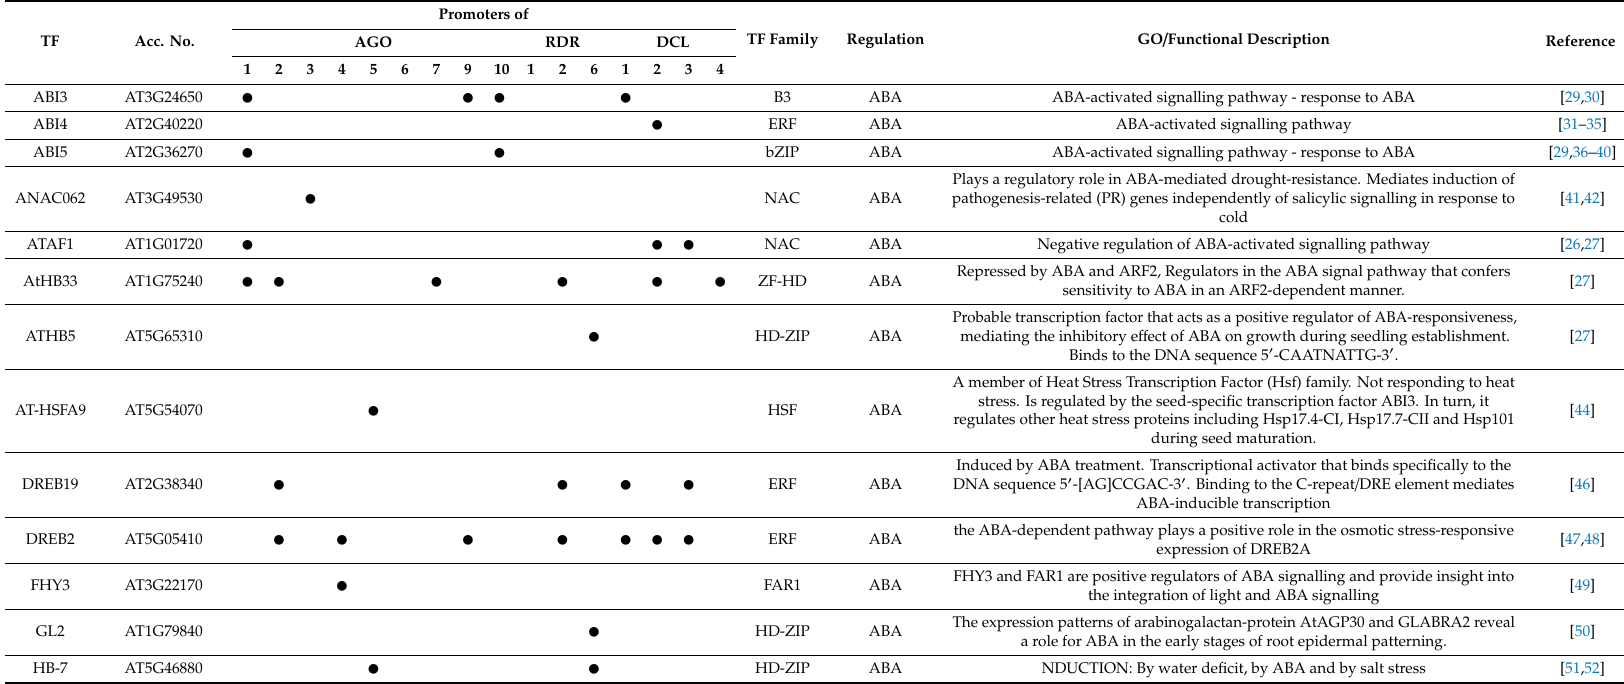
Table 1. Transcription factors that are involved in the regulation of ABA or SA responses and that can be coexpressed with silencing-related genes: TF: Transcription factor; Acc. No.: Accession number; ABA: abscisic acid; JA: Jasmonic acid; SA: salicylic acid; Et: Ethylene. References: [29] (Nakashima et al., 2006), [30] (Delmas et al., 2013), [31] (Acevedo-Hernandez et al., 2005), [32] (Kali ff et al., 2007), [33] (Shkolnik-Inbar and Bar-Zvi, 2010), [34] (Shu et al., 2013), [35] (Feng et al., 2014), [36] (Lopez-Molina et al., 2001), [37] (Carles et al., 2002), [38] (Bensmihen et al., 2002), [39] (Lopez-Molina et al., 2002), [40] (Finkelstein et al., 2005), [41] (Kim et al., 2012), [42] (Seo et al., 2010), [26] (Jensen et al., 2008), [27] (Wu et al., 2009), [43] (Lechner et al., 2011), [44] (Johannesson et al., 2003), [45] (Jiang and Yu, 2009), [46] (Sakuma et al., 2002), [47] (Lee et al., 2010), [48] (Kim et al., 2011), [49] (Tang et al., 2013), [50] (van Hengel et al., 2004), [51] (Soderman et al., 1996), [52] (Valdes et al., 2012), [53] (Chinnusamy et al., 2003), [54] (Yamamoto et al., 2009), [55] (Brocard-Gi ff ord et al., 2003), [56] (Reyes and Chua, 2007), [57] (Tran et al., 2004), [58] (Yanhui et al., 2006), [59] (Li et al., 2006), [60] (Kang and Singh, 2000), [61] (Kang et al., 2003), [62] (Johnson et al., 2003), [63] (Zander et al., 2010), [64] (Fonseca et al., 2010), [65] (Thibaud-Nissen et al., 2006), [66] (Choi et al., 2010), [67] (Zhou et al., 2000), [68] (Kang and Klessig, 2005), [69] (Duan et al., 2007), [70] (Robatzek and Somssich, 2001), [71] (Yu et al., 2001), [72] (Lai et al., 2008), [73] (Chen et al., 2010), [74] (Hu et al., 2013), [75] (Chen et al., 2013), [76] (Zhang et al., 2007), [77] (Scarpeci et al., 2013), [78] (Li et al., 2013).